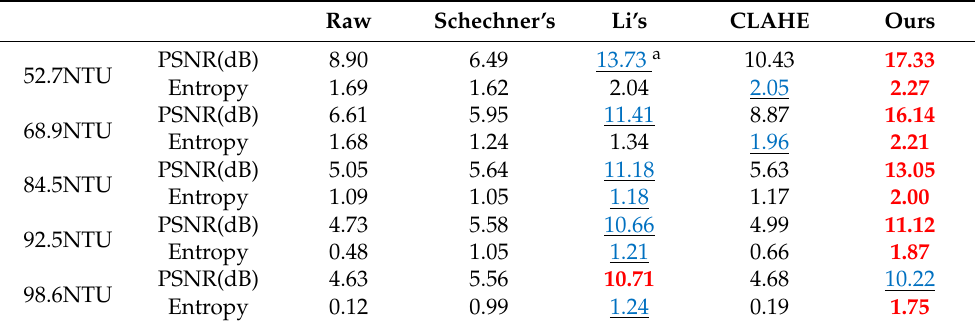
Table 1. Quantitative comparisons of the recovered images in Figure